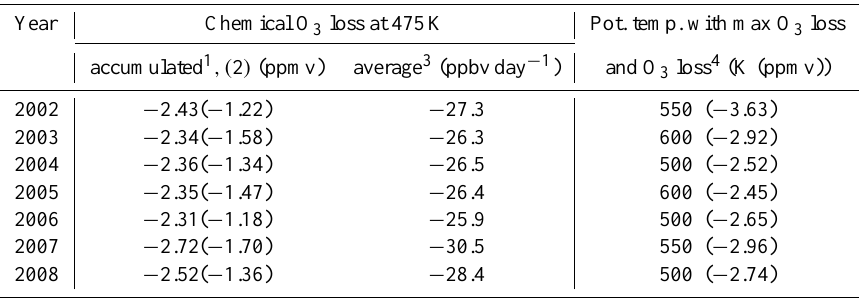
Table 2. The chemical ozone loss rates in the Antarctic polar vortex between 450K and 600K isentropic levels between 22 August and 15 November of the years 2002–2008. Note that while ozone losses below about 550K potential temperature are mainly driven by reactive halogen compounds formed by heterogeneous reactions, the losses above this level may also be affected by enhanced NO x occurring near the end of austral spring. Chemical O 3 loss at 475K Pot. temp. with max O 3 loss